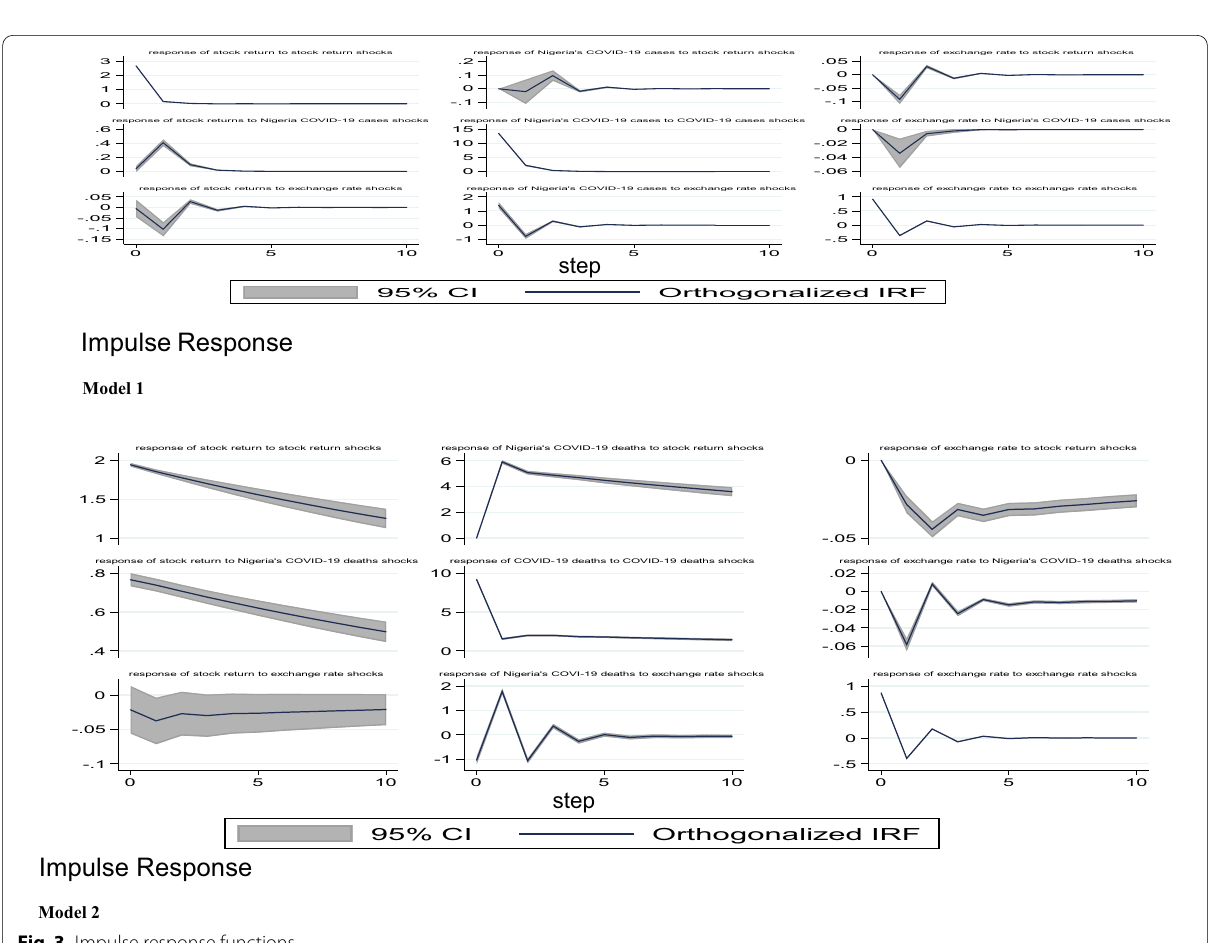
Fig. 3 Impulse response